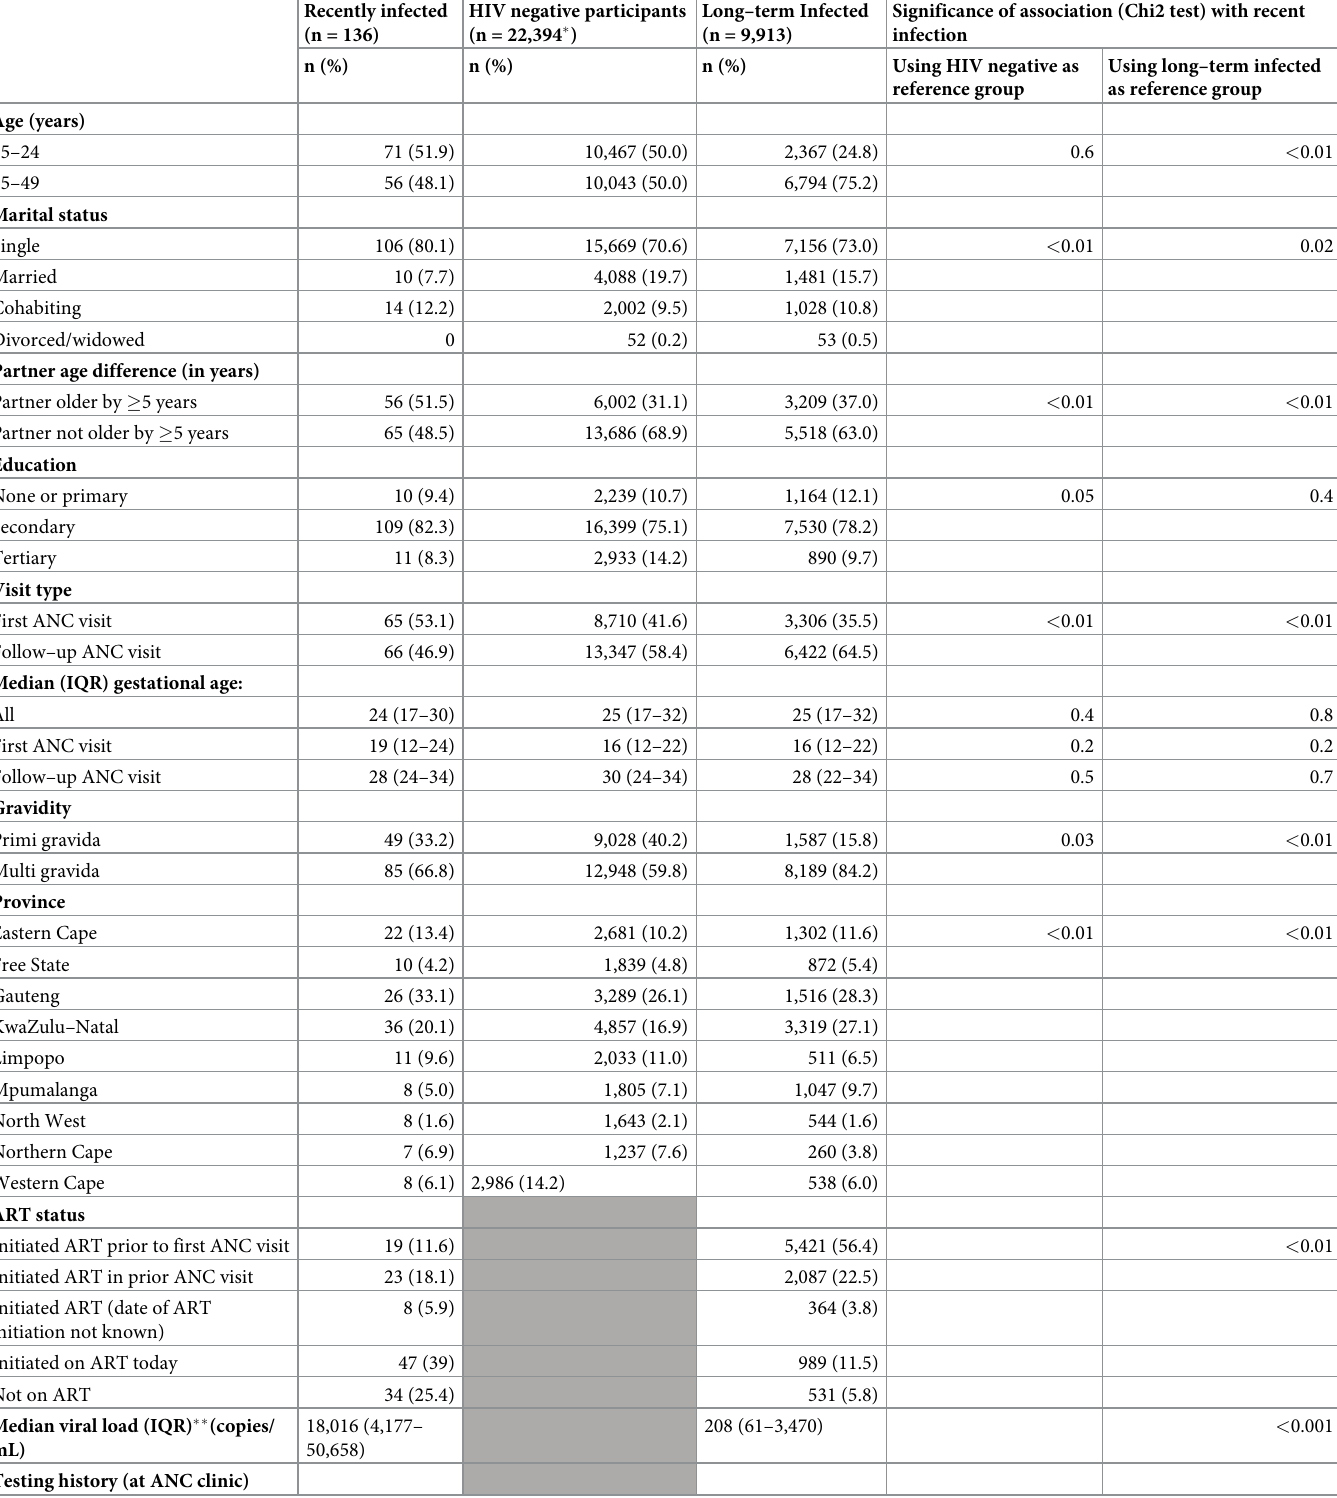
Table 1. Characteristics of recently infected, long–term infected and HIV negative pregnant women in the 2017 Antenatal HIV Sentinel Survey, South